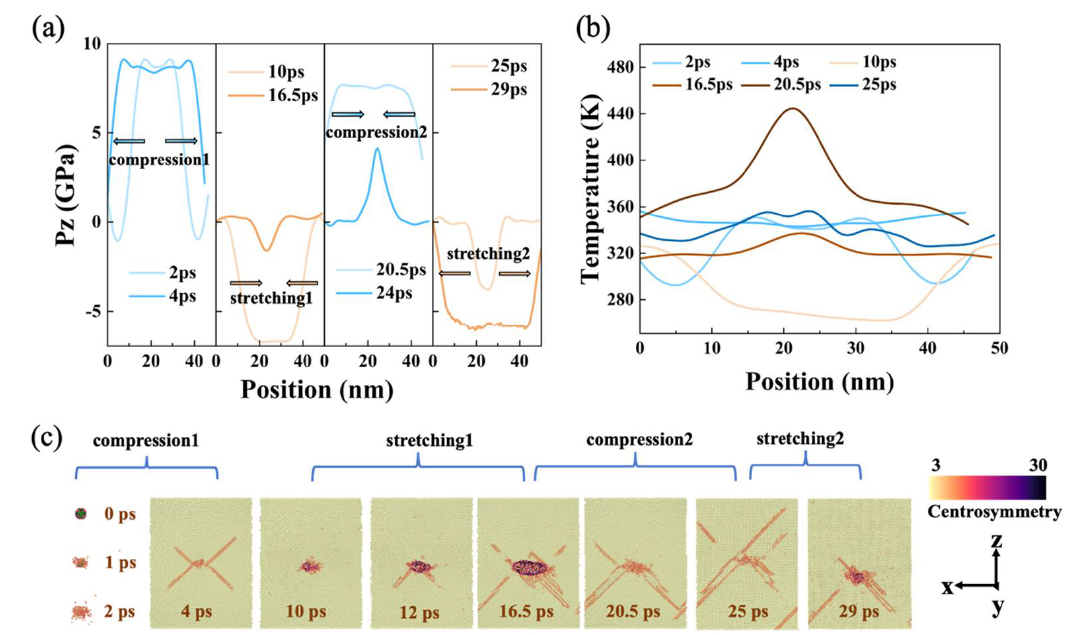
Figure 4. Evolution of ( a ) longitudinal stress profile and ( b ) temperature profile at v 0 = 0.5 km/s. ( c ) Microscopic views of void evolution at 0, 1, and 2 ps (atoms with centrosymmetry values less than 8 were deleted), 4, 10, 12, 16.5, 20.5, 25, and 29 ps (the microscopic views were sliced from the center axis).